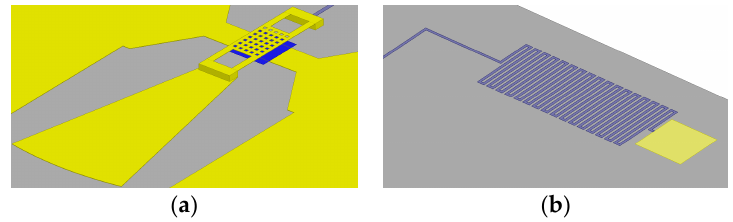
Figure 2. RF MEMS switch. ( a ) 3D model. ( b ) Bias line and pad.